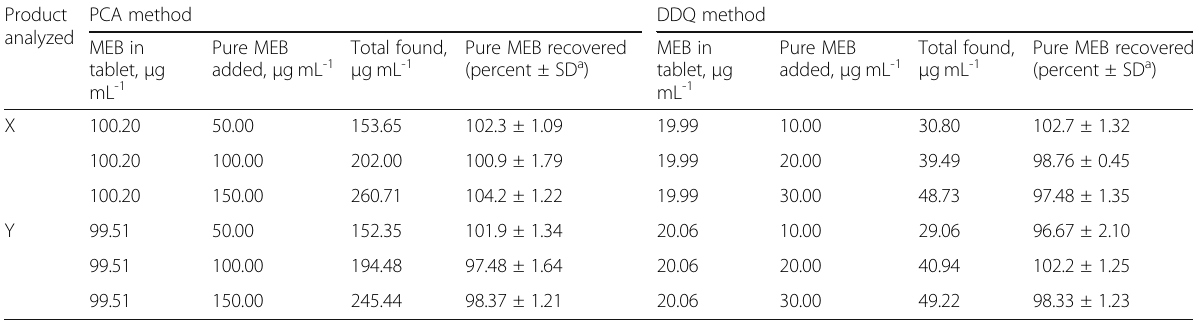
Table 6 Results obtained in accuracy assessment by recovery experiments Product PCA method analyzed